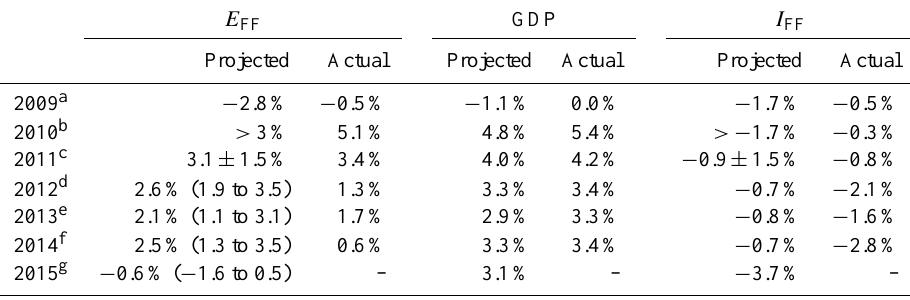
Table 9. Actual CO 2 emissions from fossil fuels and industry ( E FF ) compared to projections made the previous year based on world GDP (IMF October 2015) and the fossil fuel intensity of GDP ( I FF ) based on subtracting the CO 2 and GDP growth rates. The “Actual” values are the latest estimate available, and the “Projected” value for 2015 refers to those presented in this paper. A correction for leap years is applied (Sect.